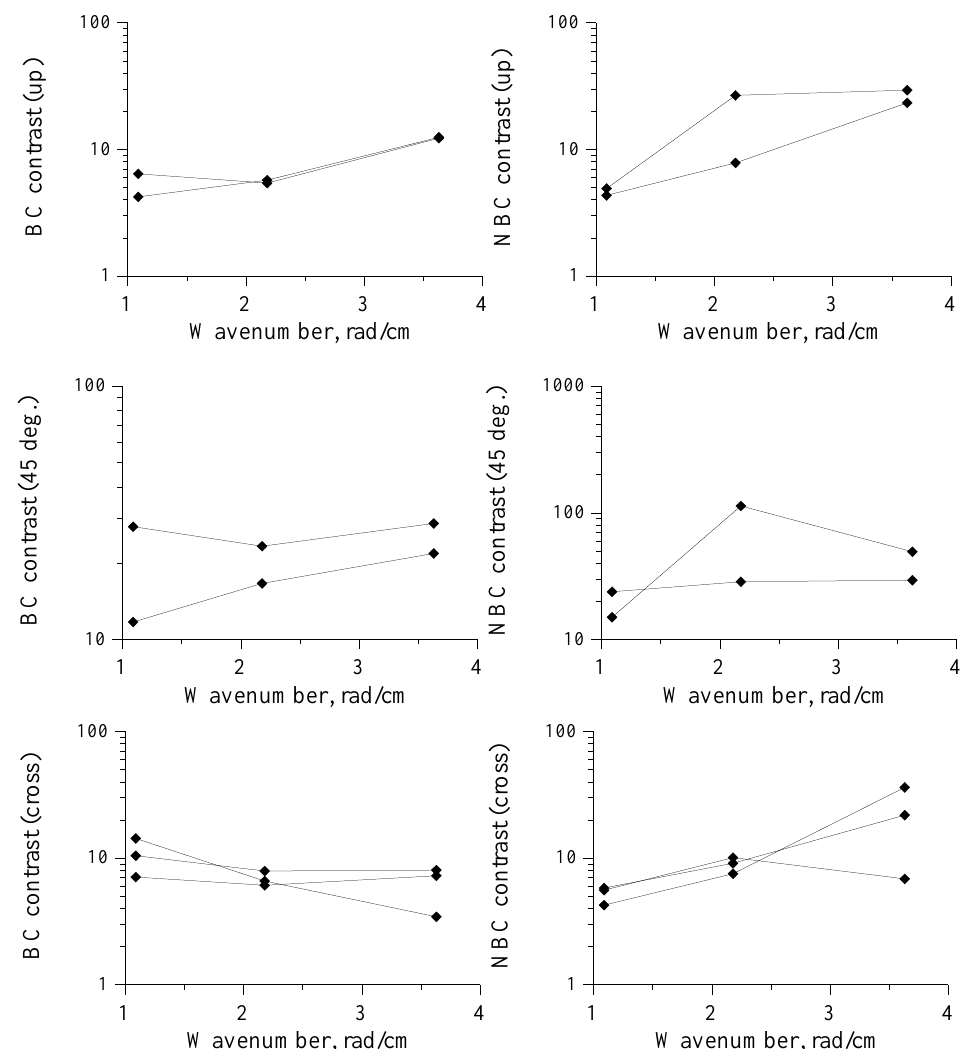
Figure 5. BC and NBC contrasts at different azimuth angles as functions of radar Bragg wavenumber. GWR, wind velocity of 5–6 m/s.